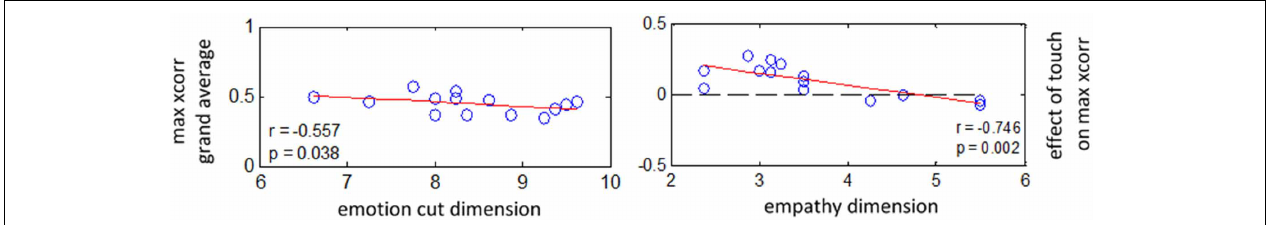
FIGURE 7 | EDA: correlations between effect of touch on interpersonal coupling and scores at empathy questionnaire. N = 14 couples. Left: Spearman correlation between grand average of maximum cross-correlation and score obtained for “splitting with